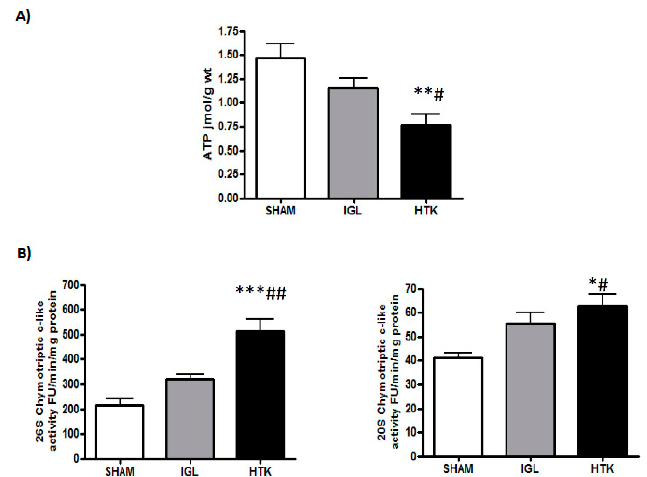
Figure 3. Energy breakdown (ATP failure) ( A ) and chymotriptic-like activity ATP-dependent (26S) and ATP-independent (20S) ( B ) determination. Results are expressed as mean ± SEM ( n = 6). * p < 0.05, ** p < 0.01 and *** p < 0.001 represent significant differences versus SHAM and # p < 0.05, ## p < 0.01 versus IGL-1.